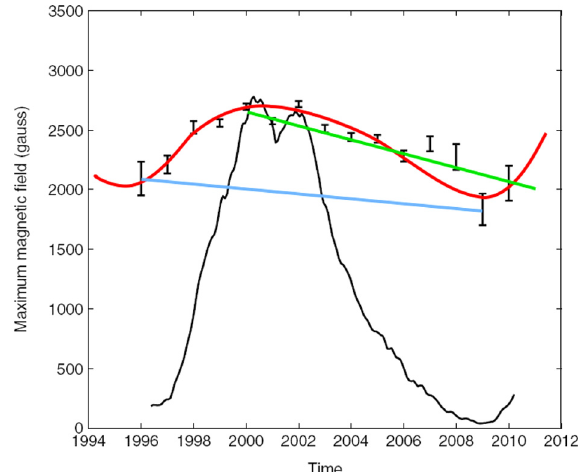
Fig. 5. Plot of the average maximum magnetic field in the core of sunspot umbrae measured in SoHO/MDI magnetograms over cycle 23. The smoothed monthly sunspot index is overplotted to show the evolution of the solar cycle (black curve). The overlaid green line corresponds to the linear trend measured by Penn & Livingston (2011). The red curve corresponds to a 11-year periodic modulation, while the blue line connecting the two last minima suggests a slight decrease in the recent minimum, though much lower than the Penn- Livingston trend ( Figure adapted from Watson & Fletcher